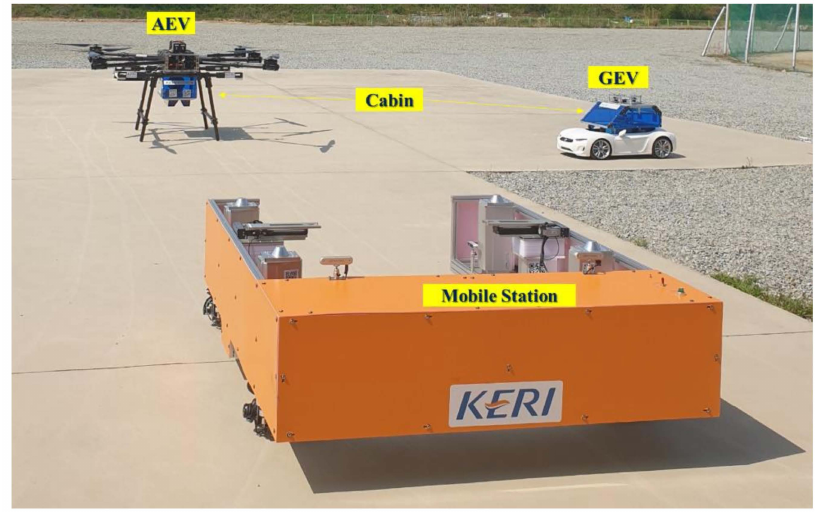
Figure 10. AEV, GEV, cabin, and mobile station used in the